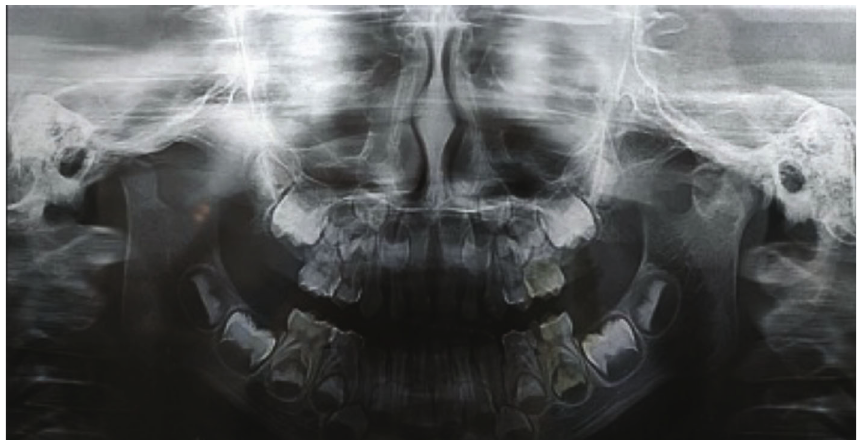
Figure 2: A pre-operative orthopantomography (OPG) of the patient.